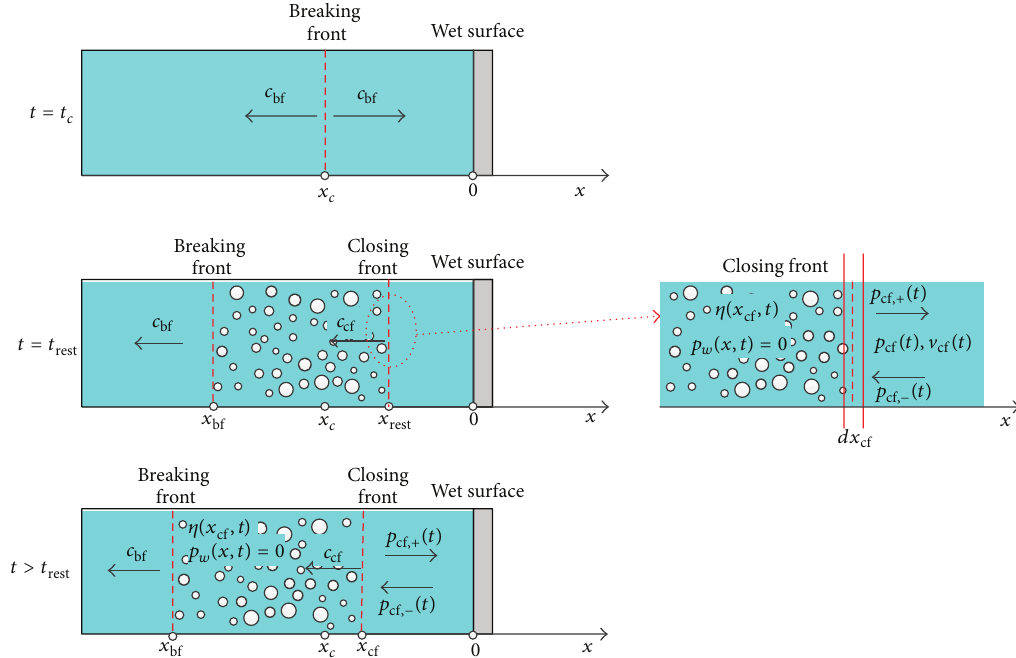
Figure 8: Schematic illustration of the phenomena of initial cavitation, emergence and propagation of breaking fronts, and development of a closing front.